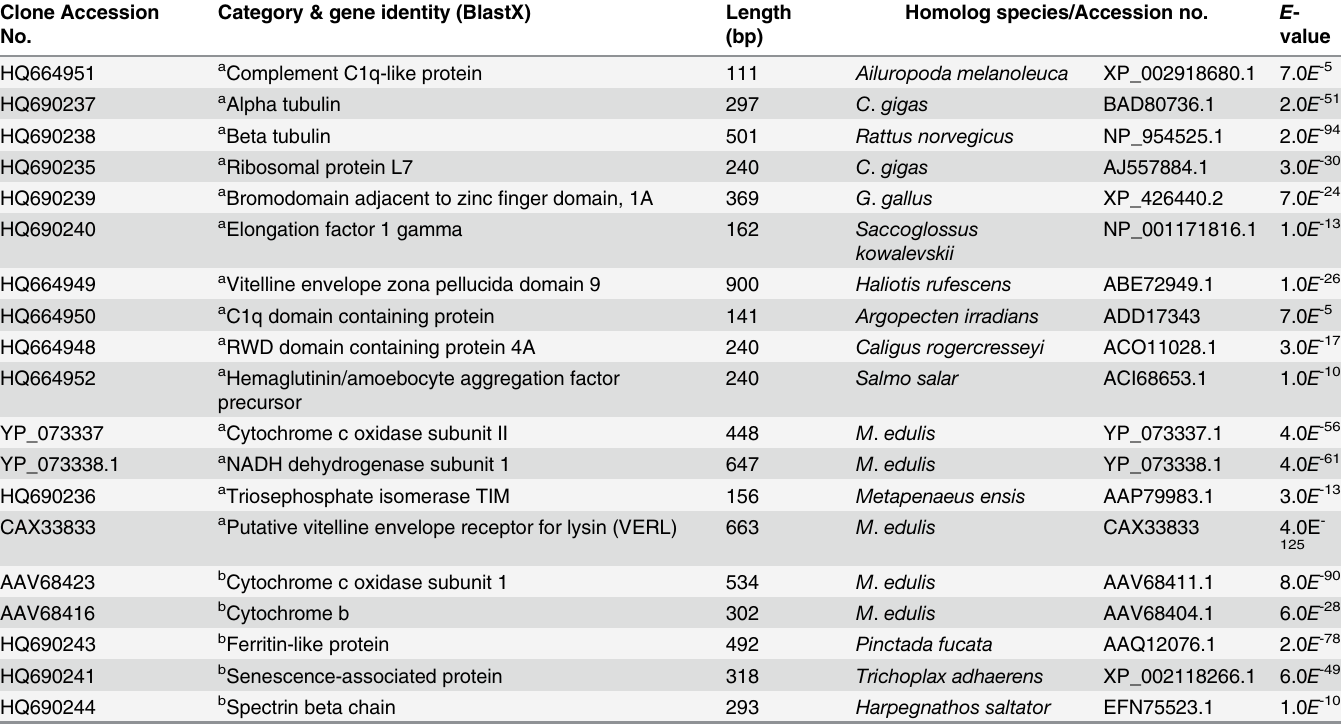
Table 2. Differentially expressed (subtracted) mRNAs identified in M . edulis testis following E2 exposure. a Down-regulated in control testes relative to E2-exposed testes. b Up-regulated in control testes relative to E2-exposed testes. Clone Accession